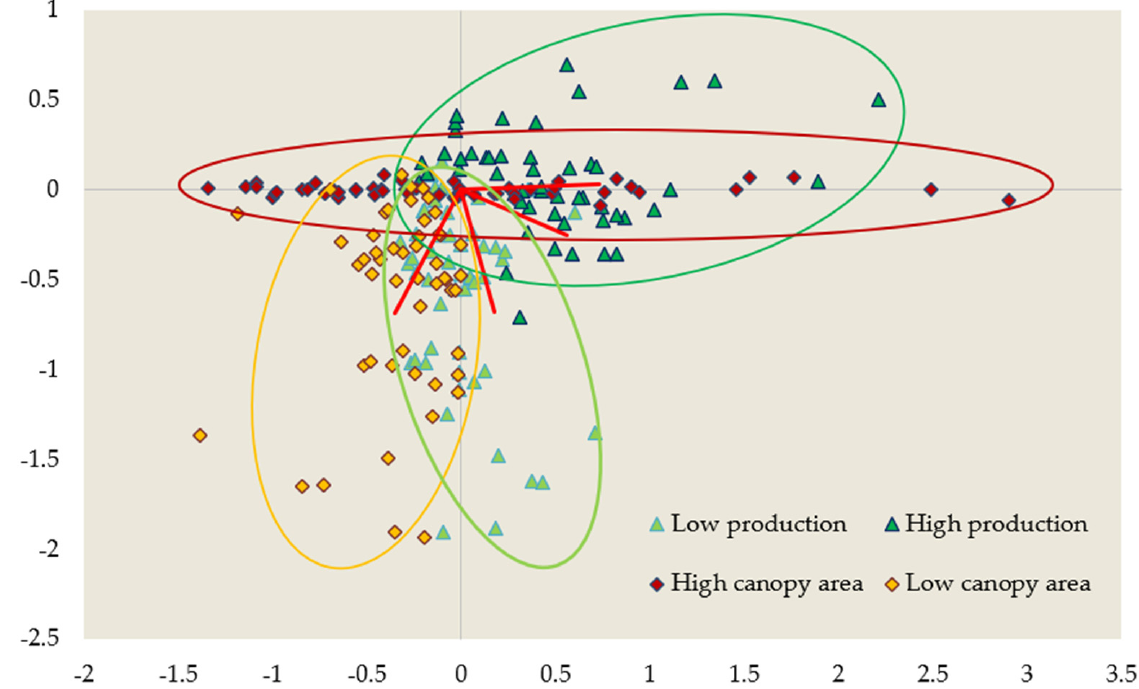
Figure 12. Principal Component Analysis (PCA) of high and low CA and production.